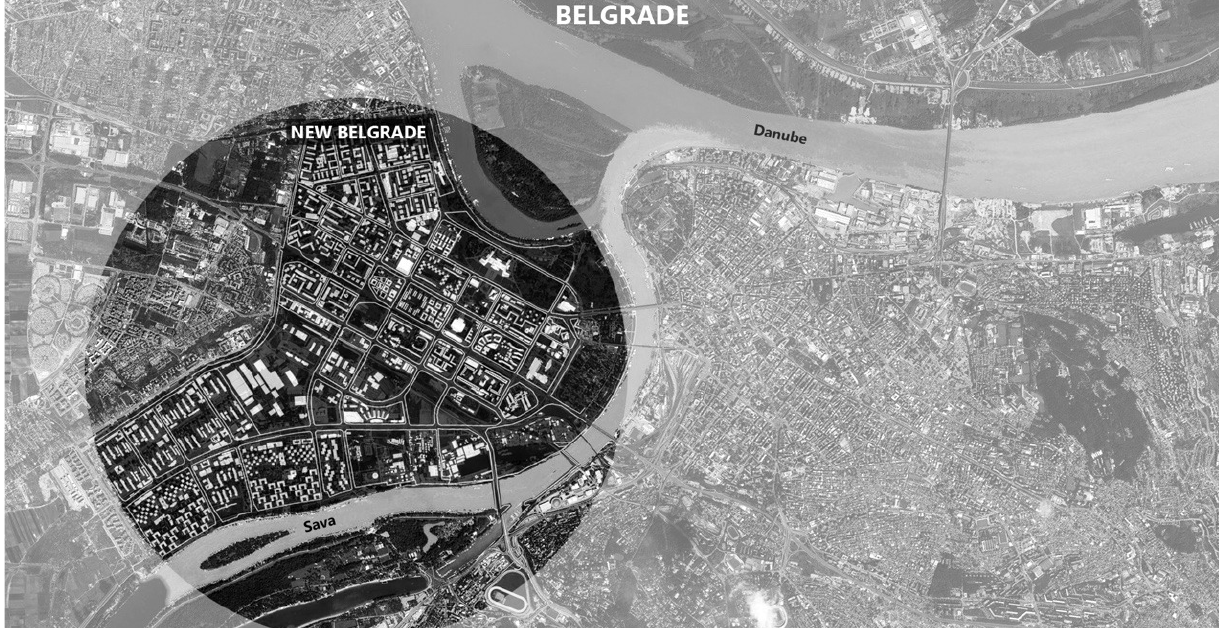
Figure 1. Map of Belgrade and New Belgrade. Source: Anica Dragutinovic, adapted from Bing Maps (https://www.bing.com/